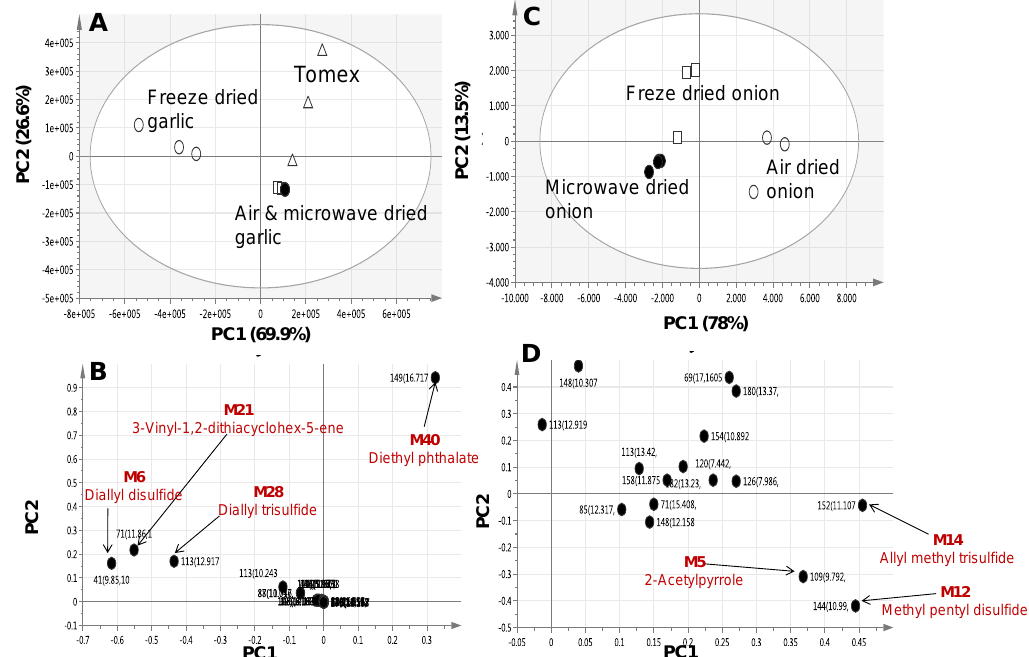
Figure 2. GC/MS based PCA score plot derived from modelling drying effect on A. sativum ( A ); A. cepa red cv. ( C ) one at a time separately to assess the effect of drying on metabolite composition ( n = 3). The loading plot from A. sativum ( B ) and A. cepa red cv; ( D ) shows the most variant masses detected using GC/MS and contributing to the samples segregation. Volatiles are denoted with m/z/retention time (sec) pair and identifications are discussed in text. M6—diallyl-disulphide, M21—3-Vinyl-1,2-dithiacyclohex-5-ene, M28—diallyl trisulphide, and M40—diethyl phthalate. Peak numbering follows those listed in (Table 1) for volatiles identification using SPME-GC/MS.